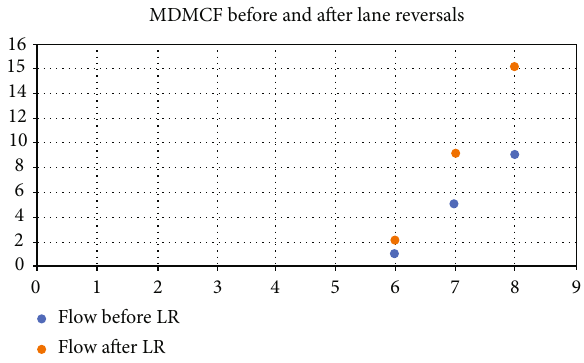
Figure 5: Comparison of fl ow before and after lane